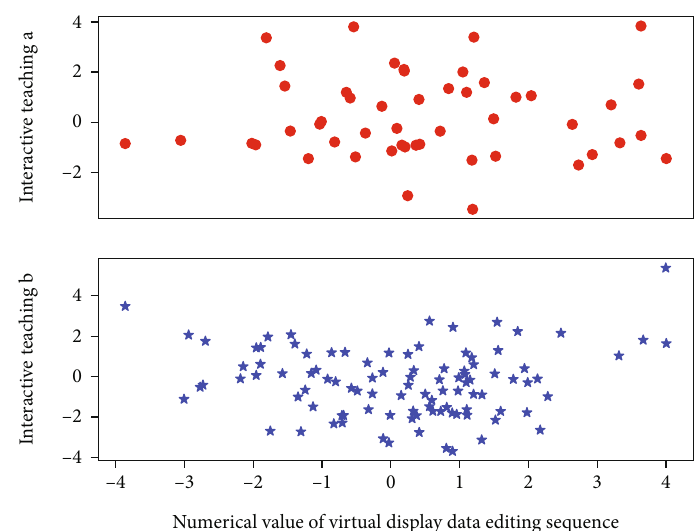
Figure 5: Interactive teaching virtual display data